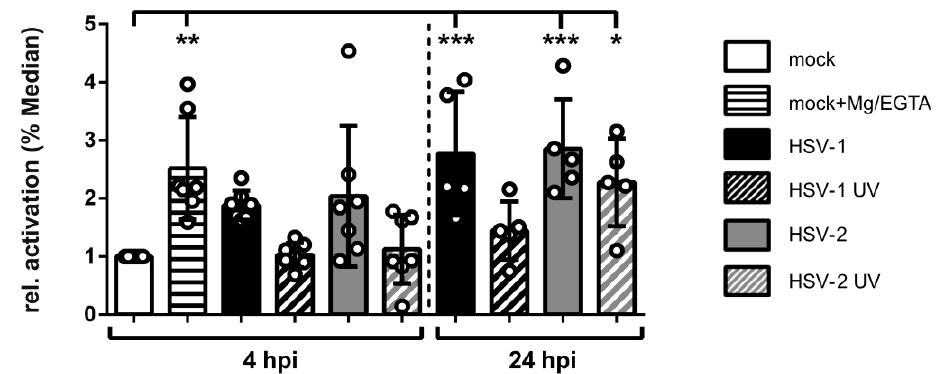
Figure 8. HSV-2 induces β 2 integrin activity very early after infection. Mock- (white bars), HSV-1- (MOI of 2, black filled bars), HSV-1 UV- (MOI of 2; 8 × 0.12 J / cm 2 , black striped bar), HSV-2- (MOI of 5; gray filled bars), or HSV-2 UV-infected (MOI of 5; 8 × 0.12 J / cm 2 , gray striped bar) mDCs were harvested 4 hpi and 24 hpi. As positive control, mock-treated cells were treated with or without Mg / EGTA 4 hpi as indicated. Cells were stained with the antibody mAb24 specific for the activated epitope of CD11a / CD18 ( β 2) integrins, or the respective isotype control, and analyzed via flow cytometry. Changes in β 2 integrin activity for the indicated conditions are shown as ∆ Median (mAb24-isotype) relative to mock-infected mDCs (white bar; set to “1”). The experiment was performed five (24 hpi) to seven (4 hpi) times with cells of di ff erent healthy donors. Error bars indicate ± SD. Significant changes (*** = p < 0.001; ** = p < 0.01; * = p < 0.05) are marked by asterisks.